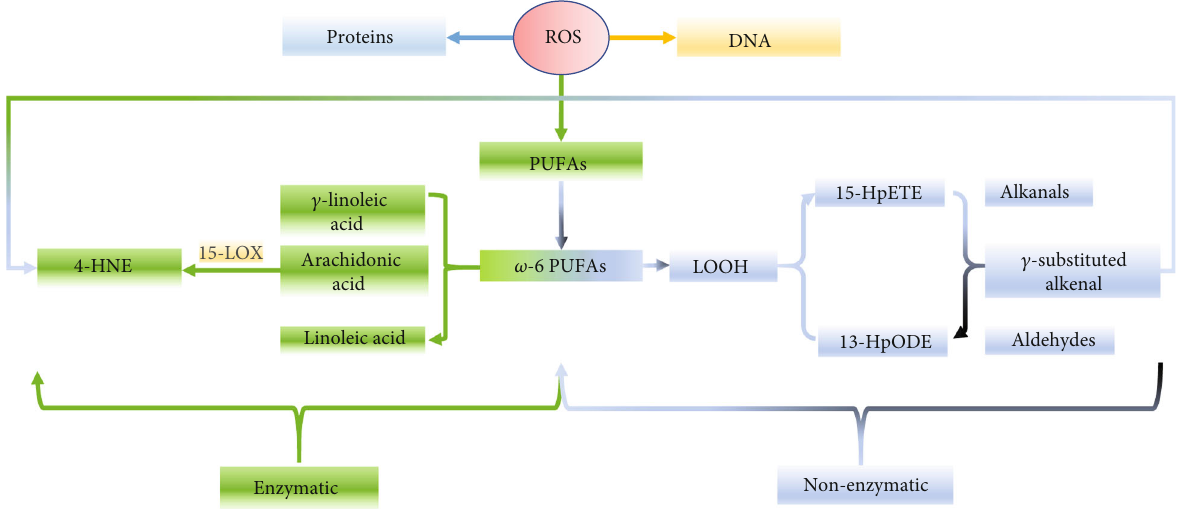
Figure 1: Production pathway of 4-hydroxy-2-nonenal (4-HNE). 4-HNE is produced by non-enzymatic and enzymatic pathways in ω -6 PUFAs induced by